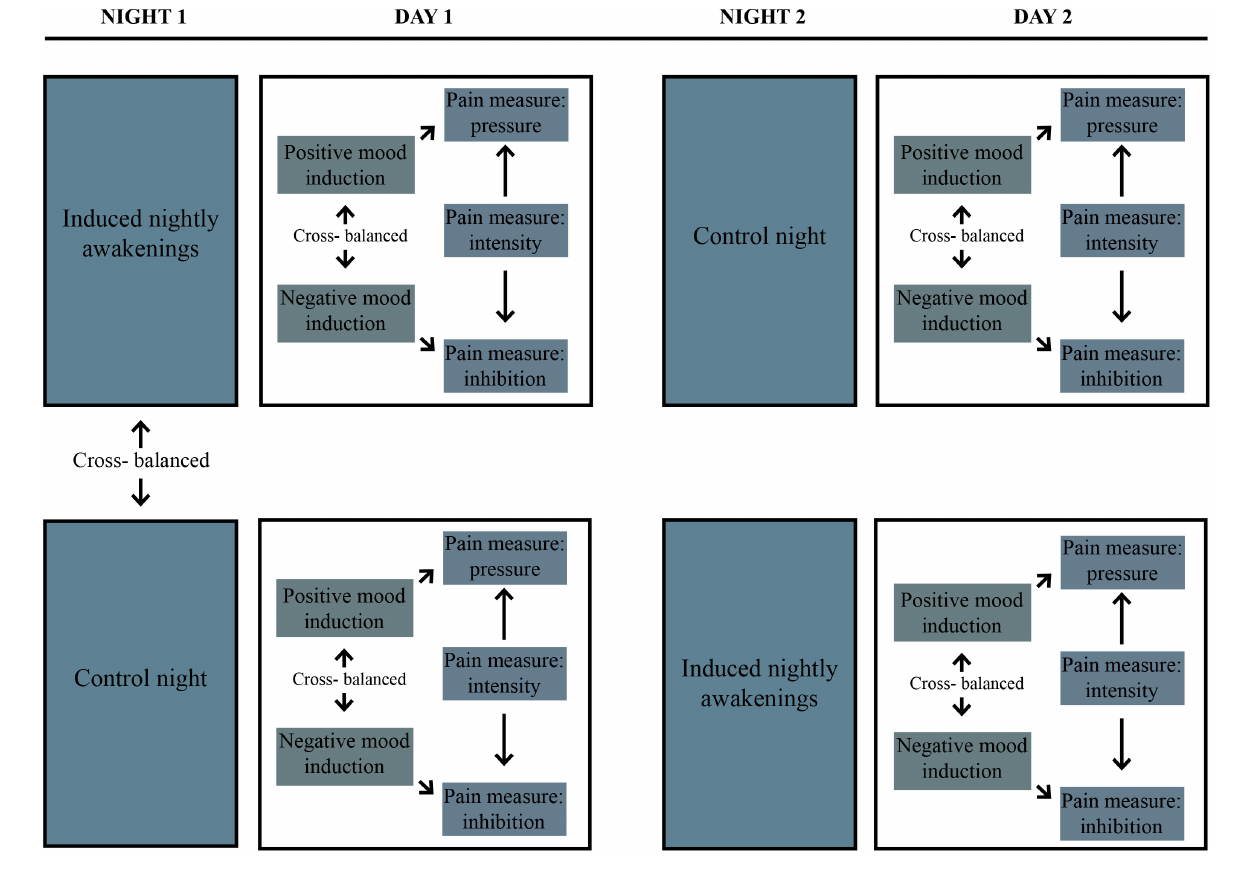
FIGURE 1 | Overview of the experimental protocol